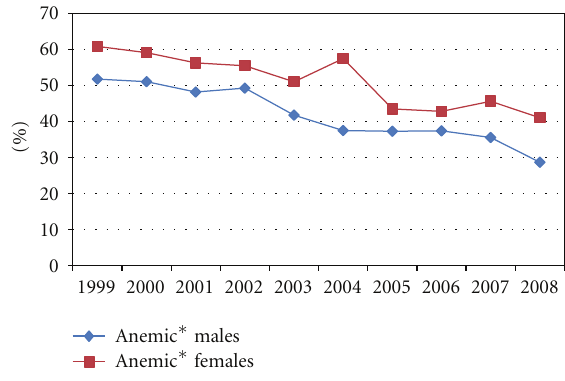
Figure 3: Prevalence of hypoviscosity in anemic patients. ∗ Anemia according to regional pathology is adult male with either “Hb < 130g/L” or “hct < 36%”; adult females “Hb < 115g/L” or “hct < 32%”.